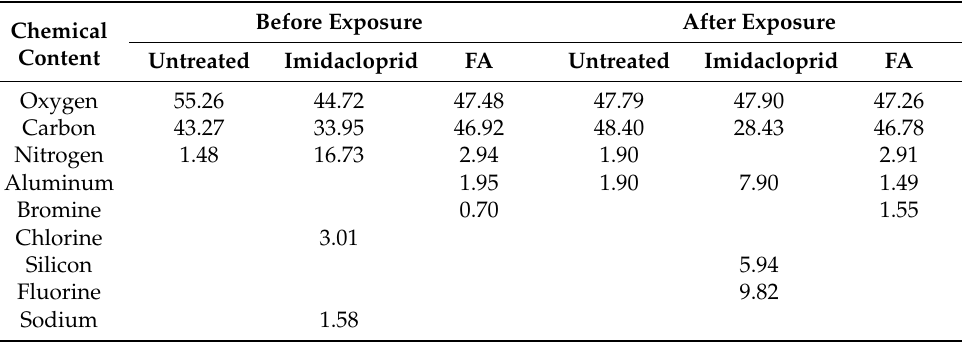
Table 9. Chemical content of jabon wood according to EDX analysis.